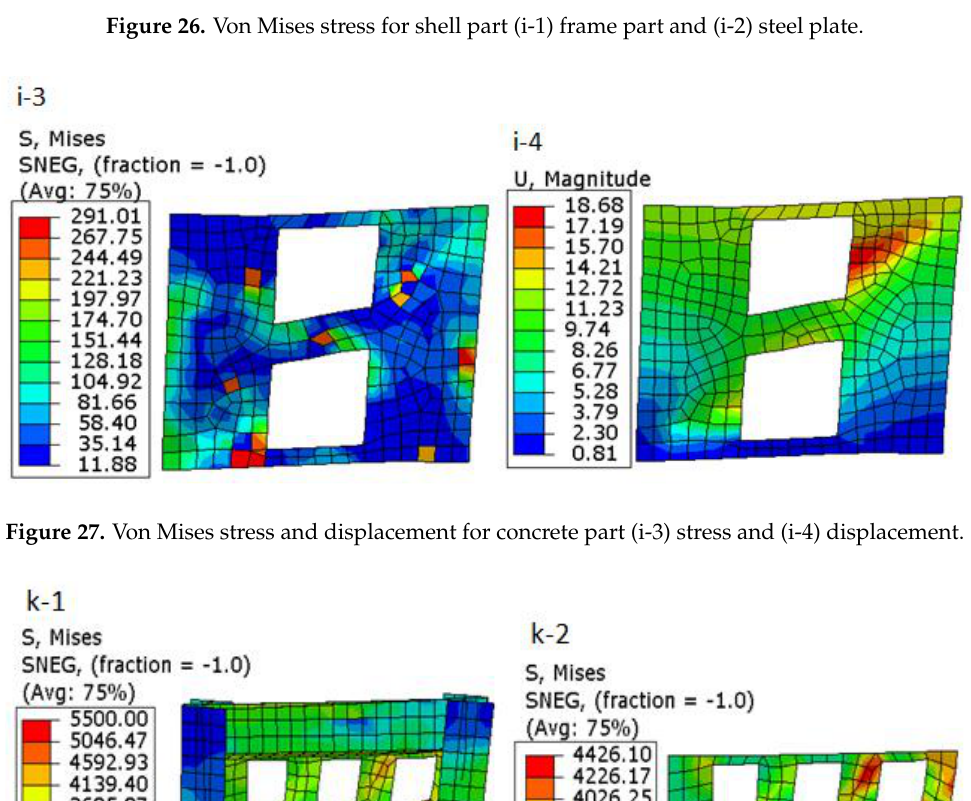
Figure 26. Von Mises stress for shell part (i-1) frame part and (i-2) steel plate. Buildings 2018 , 8 , x FOR PEER REVIEW